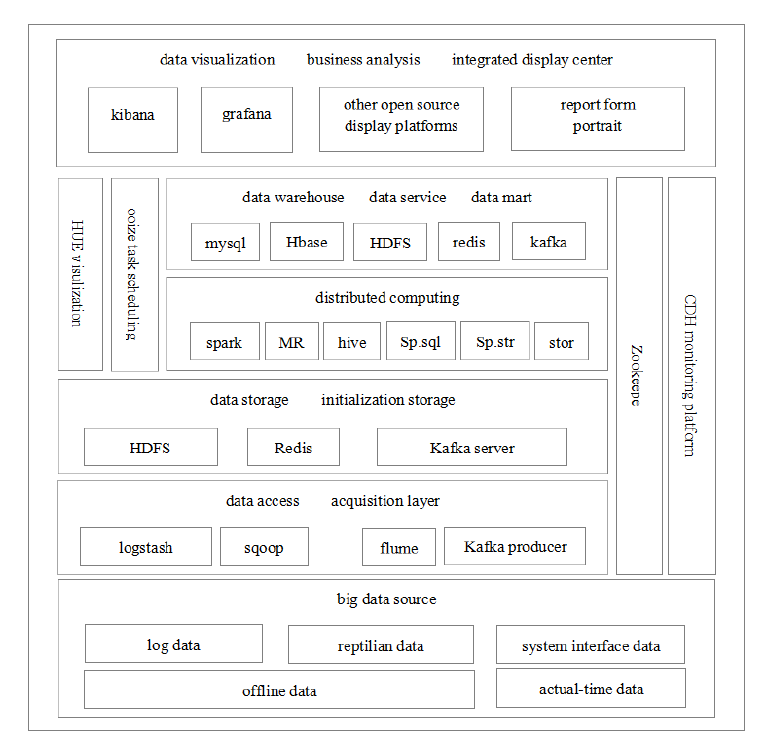
Fig. 5. Complex Technological Systems Involved in Big information